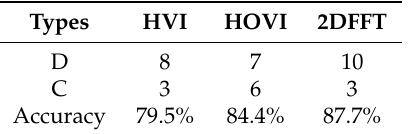
Table 4. Best accuracy of single feature combination.